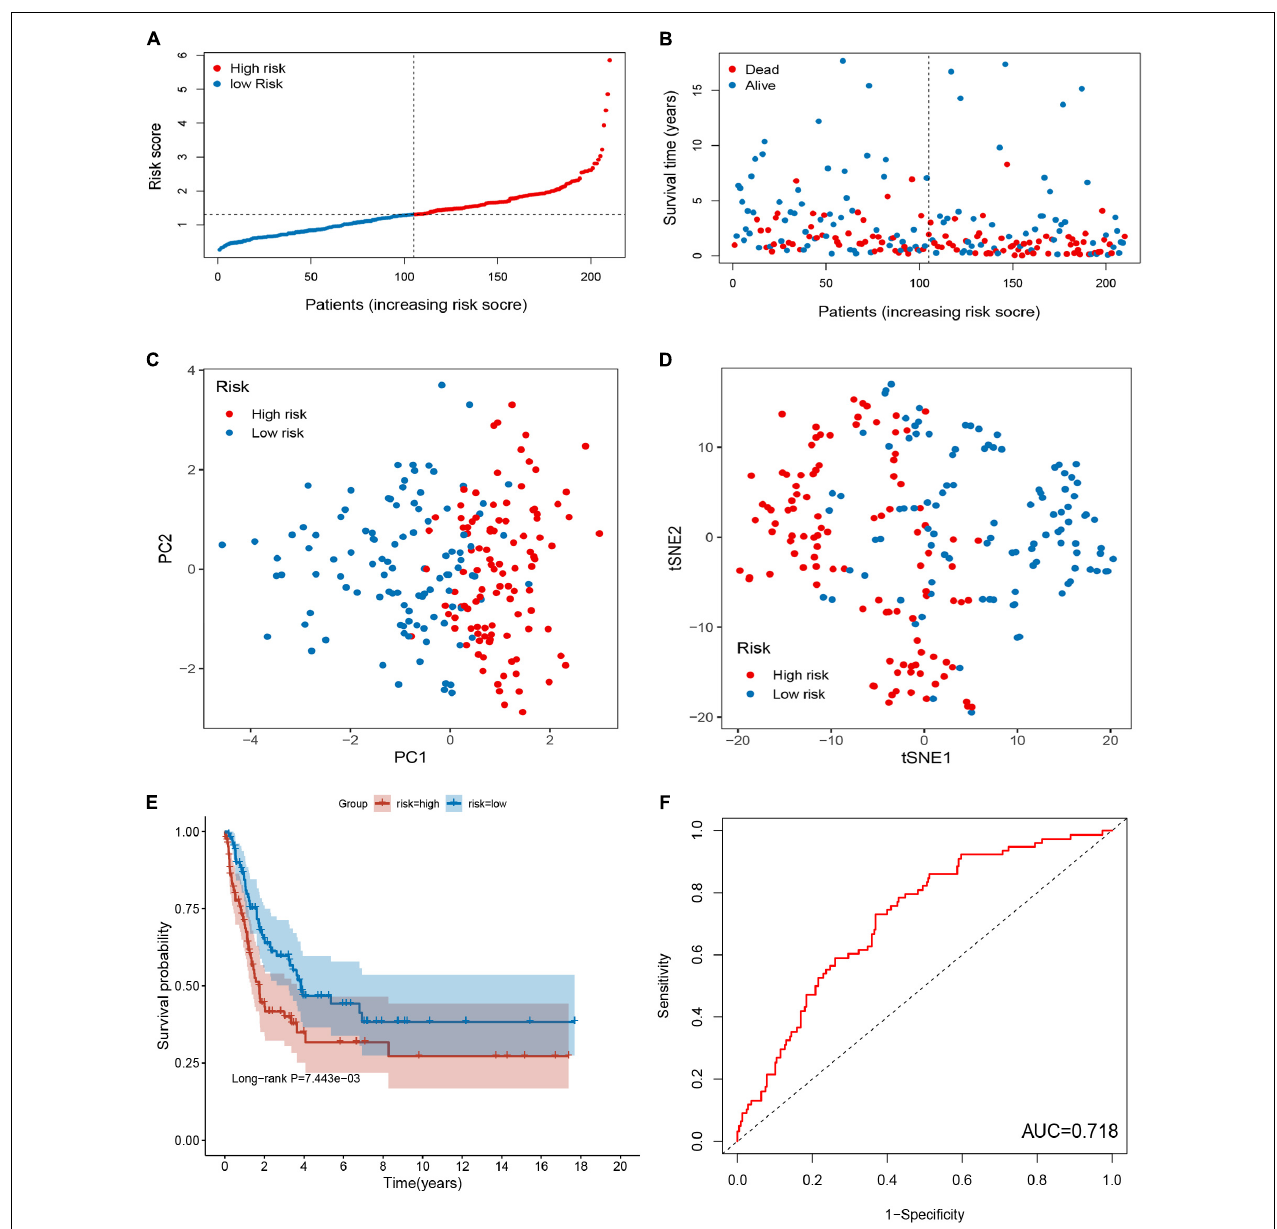
FIGURE 3 | Evaluation of 7-RBP signature in GSE65904 dataset. (A) The ranked dot plot indicates the risk score distribution. (B) Scatter plot presenting the patients’ survival status. (C,D) The PCA and t-SNE analyses were performed between the two risk groups. (E) KM analysis of the OS between the two groups. (F) ROC curve of 7-RBP